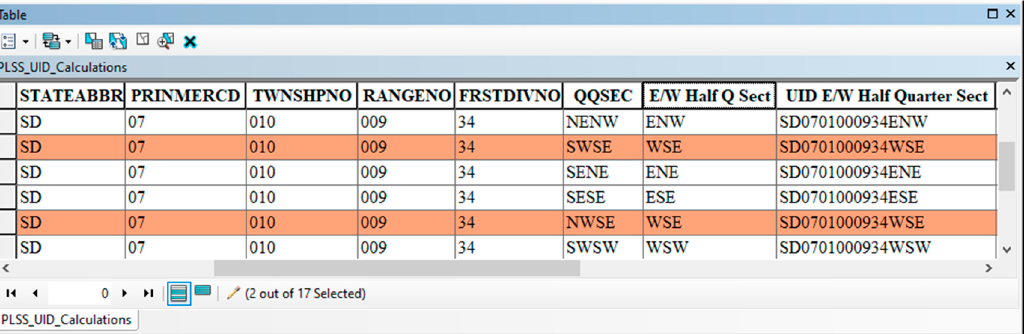
Figure 9. PLSS attribute table opened in ArcGIS. A field calculation in step 3 of Figure 4 is used to concatenate attribute values and generate Unique IDs. This example creates eastern and western half-quarter sections by removing the first character of the QQSEC field values, which are then concatenated together with other PLSS attributes to create the final aliquot Unique IDs. See Figure 8 for Field Calculation equation.